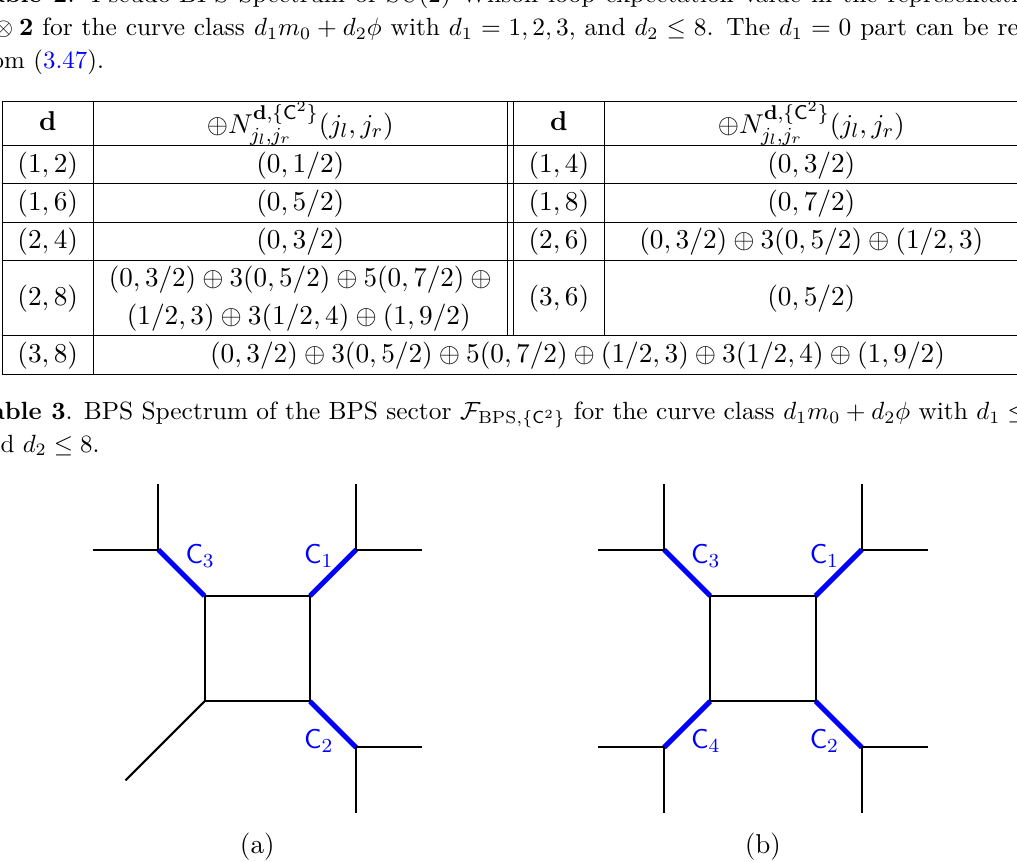
Figure 6 . Brane diagrams for SU(2) gauge theory with (a) three flavors and (b) four flavors. In the extremely massive limit, the Wilson loops for SU(2) theory are introduced by inserting curves C i , i = 1 , · · · 4